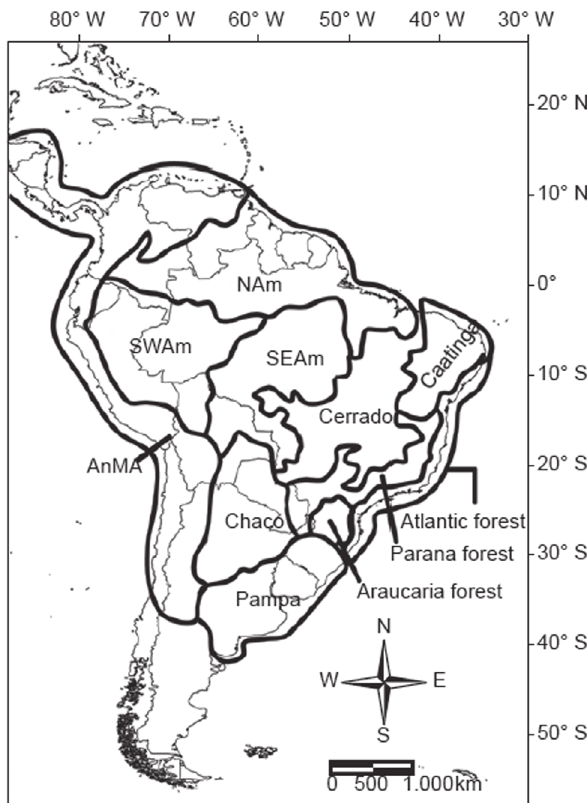
Figure 4. Endemic areas for the Neotropical region, modified from